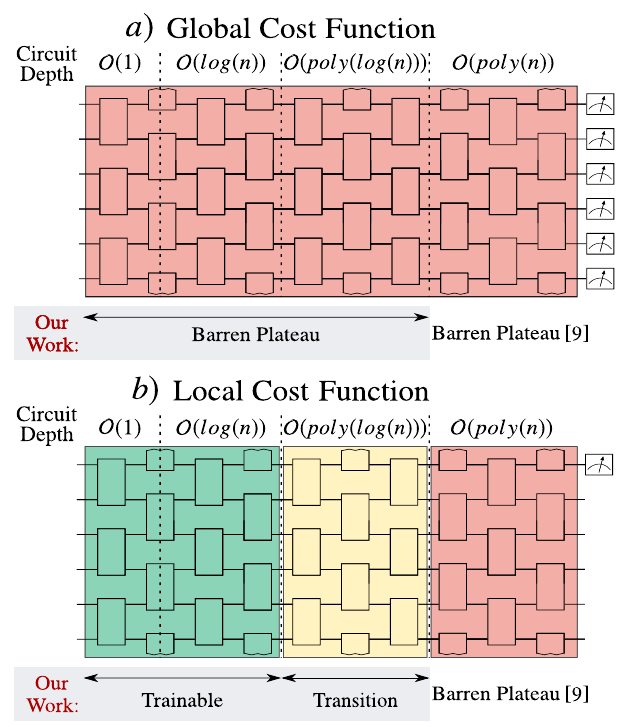
Fig. 1 Summary of our main results. McClean et al. 9 proved that a barren plateau can occur when the depth D of a hardware-ef fi cient ansatz is D 2 O ð poly ð n ÞÞ . Here we extend these results by providing bounds for the variance of the gradient of global and local cost functions as a function of D . In particular, we fi nd that the barren plateau phenomenon is cost-function dependent. a For global cost functions (e.g., Eq. (1)), the landscape will exhibit a barren plateau essentially for all depths D . b For local cost functions (e.g., Eq. (2)), the gradient vanishes at worst polynomially and hence is trainable when D 2 O ð log ð n ÞÞ , while barren plateaus occur for D 2 O ð poly ð n ÞÞ , and between these two regions the gradient transitions from polynomial to exponential